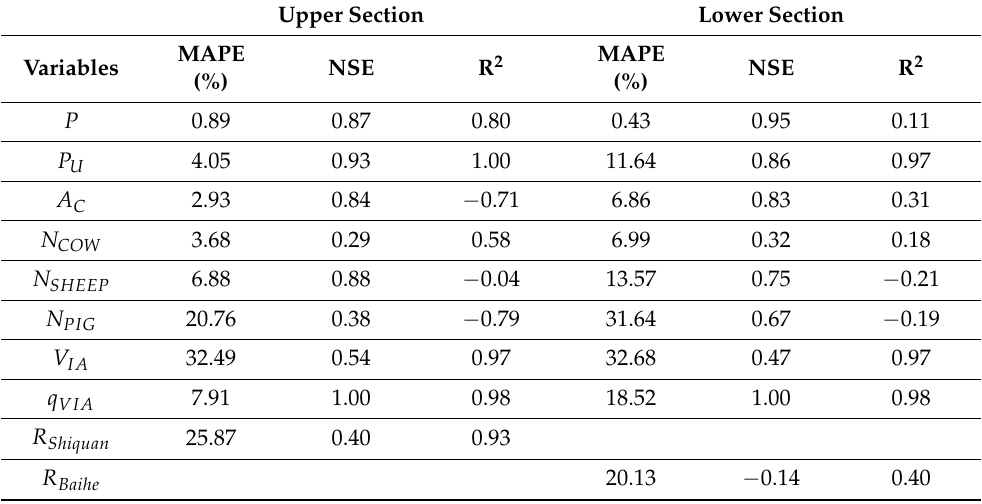
Table 5. The evaluation results in the validation period